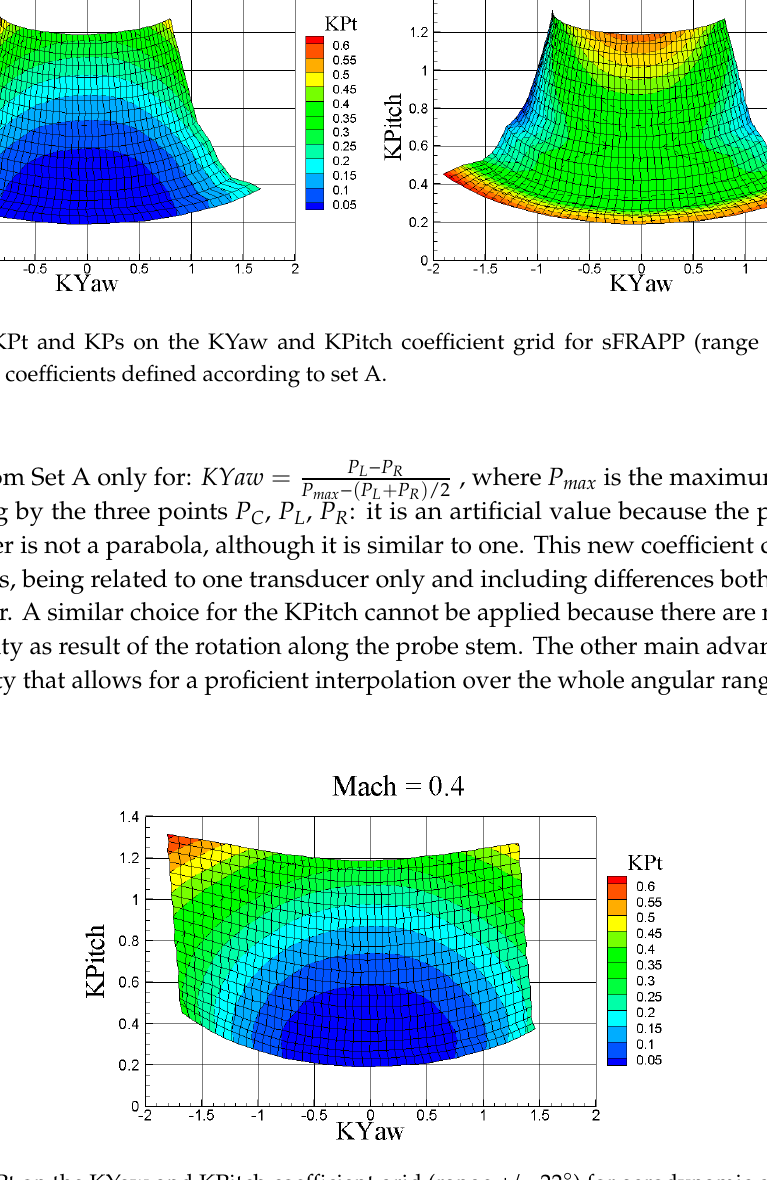
Figure 11. KPt on the KYaw and KPitch coefficient grid (range +/- 22°) for aerodynamic coefficients defined according to set B.